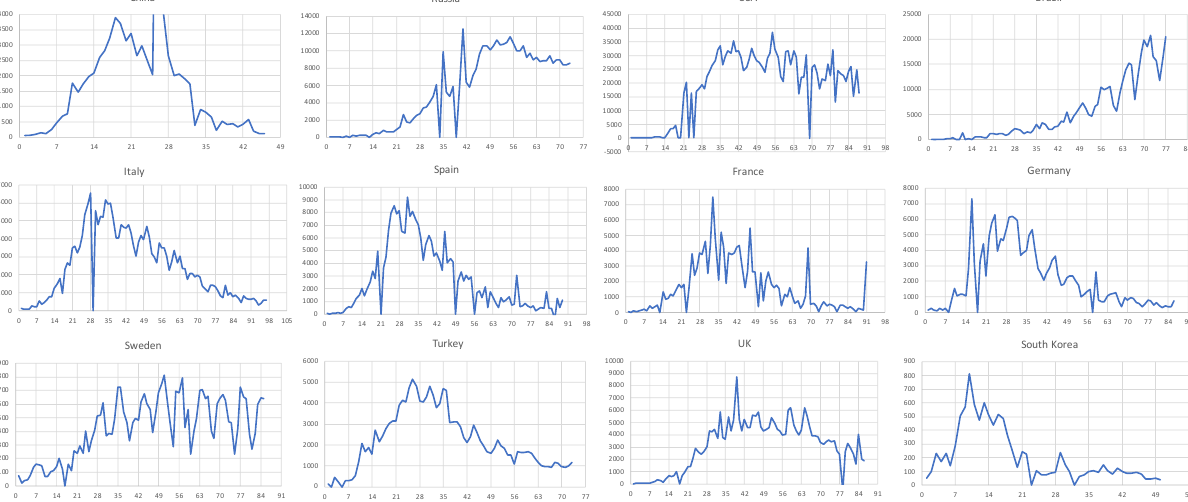
Figure 3. Patterns of daily confirmed cases in different countries/regions starting from the 100 th case (12). Data retrieved the 29 th May 2020. The horizontal scale is in unit of 7 days to put into evidence the weekly oscillations. Notice that in many cases there in an evident effects of data collection, for instance in Chine there is a jump to 16,000 cases in one day (out of scale), and in Russia there is twice an evident one-day shift of data so that the data jumps to zero are followed by a peak due to the shift. This occurs also in France while in Germany there is a possible anticipation (due to ill-registration) of data. In other countries (Italy, Spain) this shift also occurs, but without the subsequent peaks. However, in many cases there are many variations that cannot be ascribed to data shifts, since they occur over many days. There is often an evident weekly pattern, although not always so regular to be ascribed to data